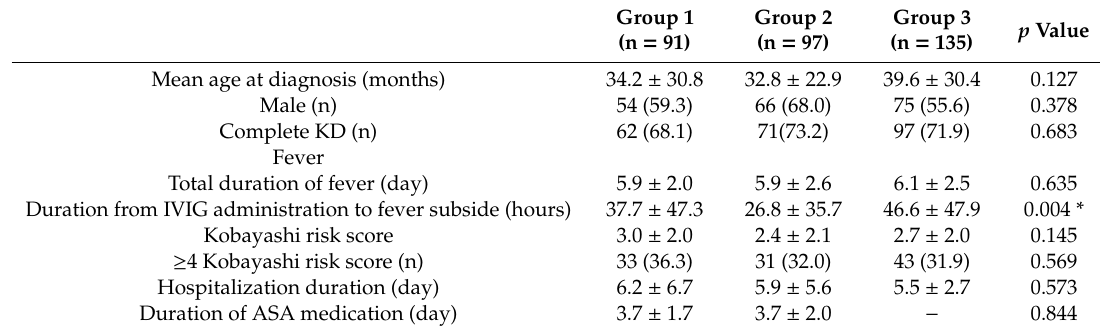
Table 1. General characteristics of Kawasaki disease patients by